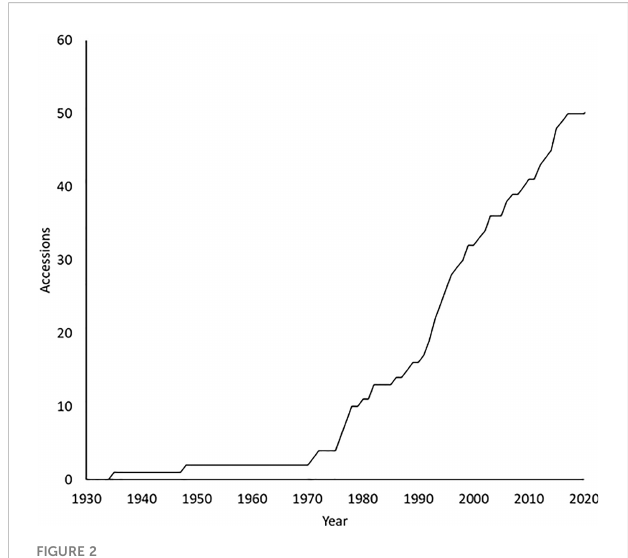
FIGURE 2 Accession over time by Russia to international institutional arrangements related to biodiversity